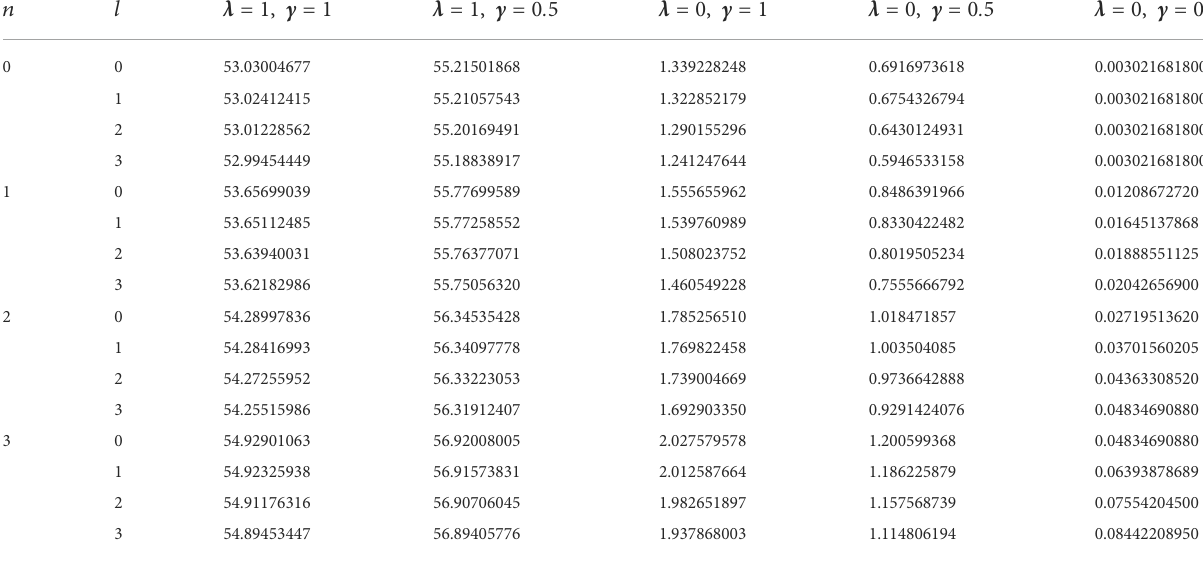
TABLE 4 Energy eigenvalues (− E nl ( eV )) of the shifted screened Kratzer potential for HCl .